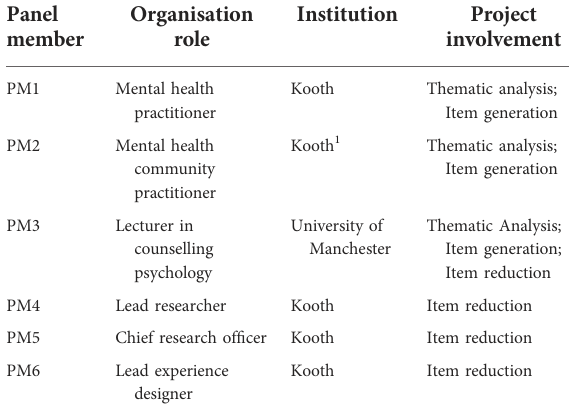
TABLE 1 Expert panel members for item